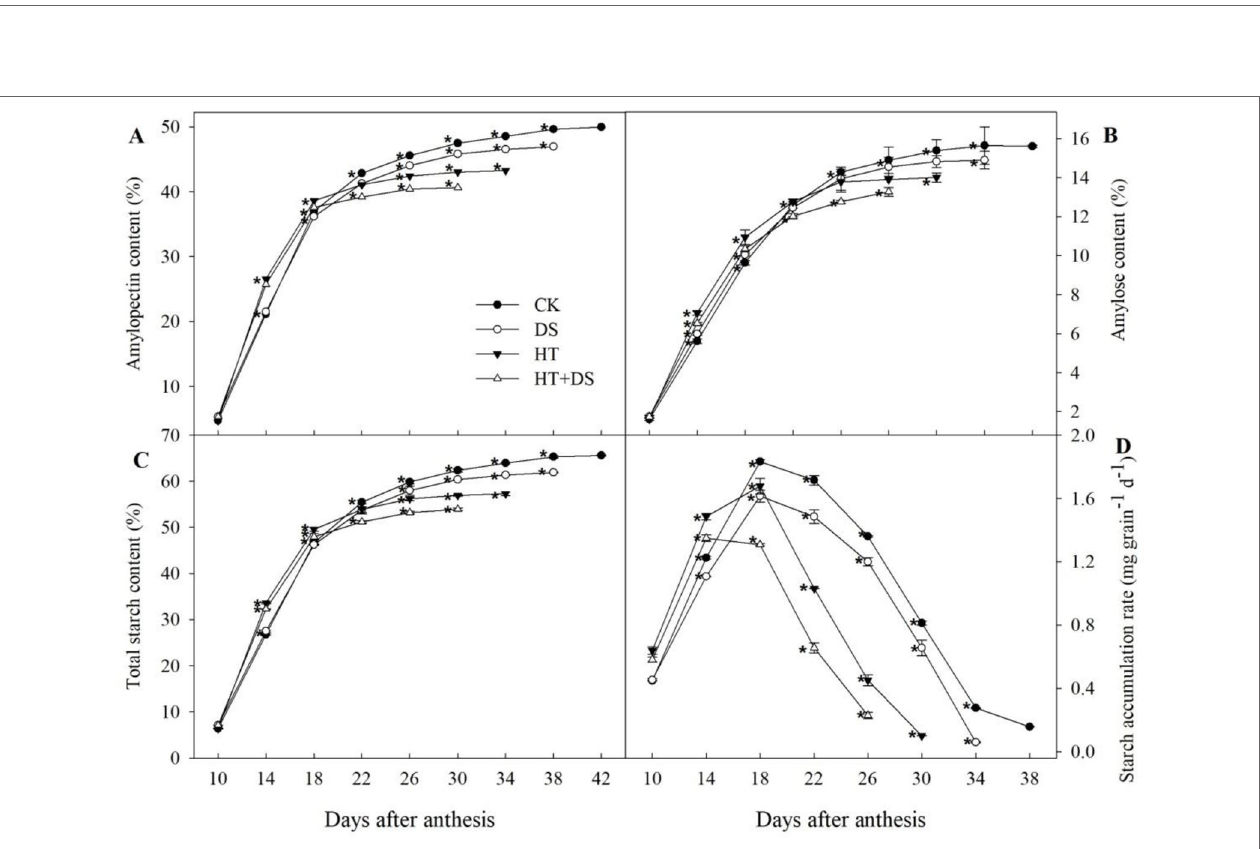
FIGUrE 5 | Dynamic changes in amylopectin (A) , amylose (B) , total starch content (c) , and the starch accumulation rate (D) in wheat grains in response to temperature and drought stress treatments. Filled circles, control (CK); open circles, drought treatment (DS); filled triangles, high temperature treatment (HT); open triangles, HT+DS treatment. Grains were assayed from 10 to 42 days after anthesis (A and c) , and from 10 to 38 days after anthesis (B and D) . Asterisks (*) indicate significant differences (p 0.05) between the individual treatments (CK, DS, HT, HT+DS).